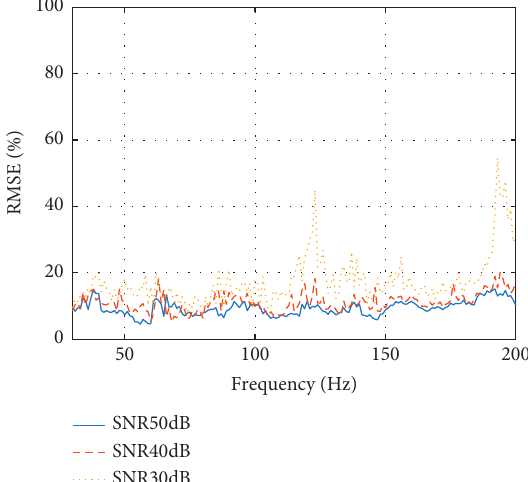
Figure 7: RMSEs under different SNRs.